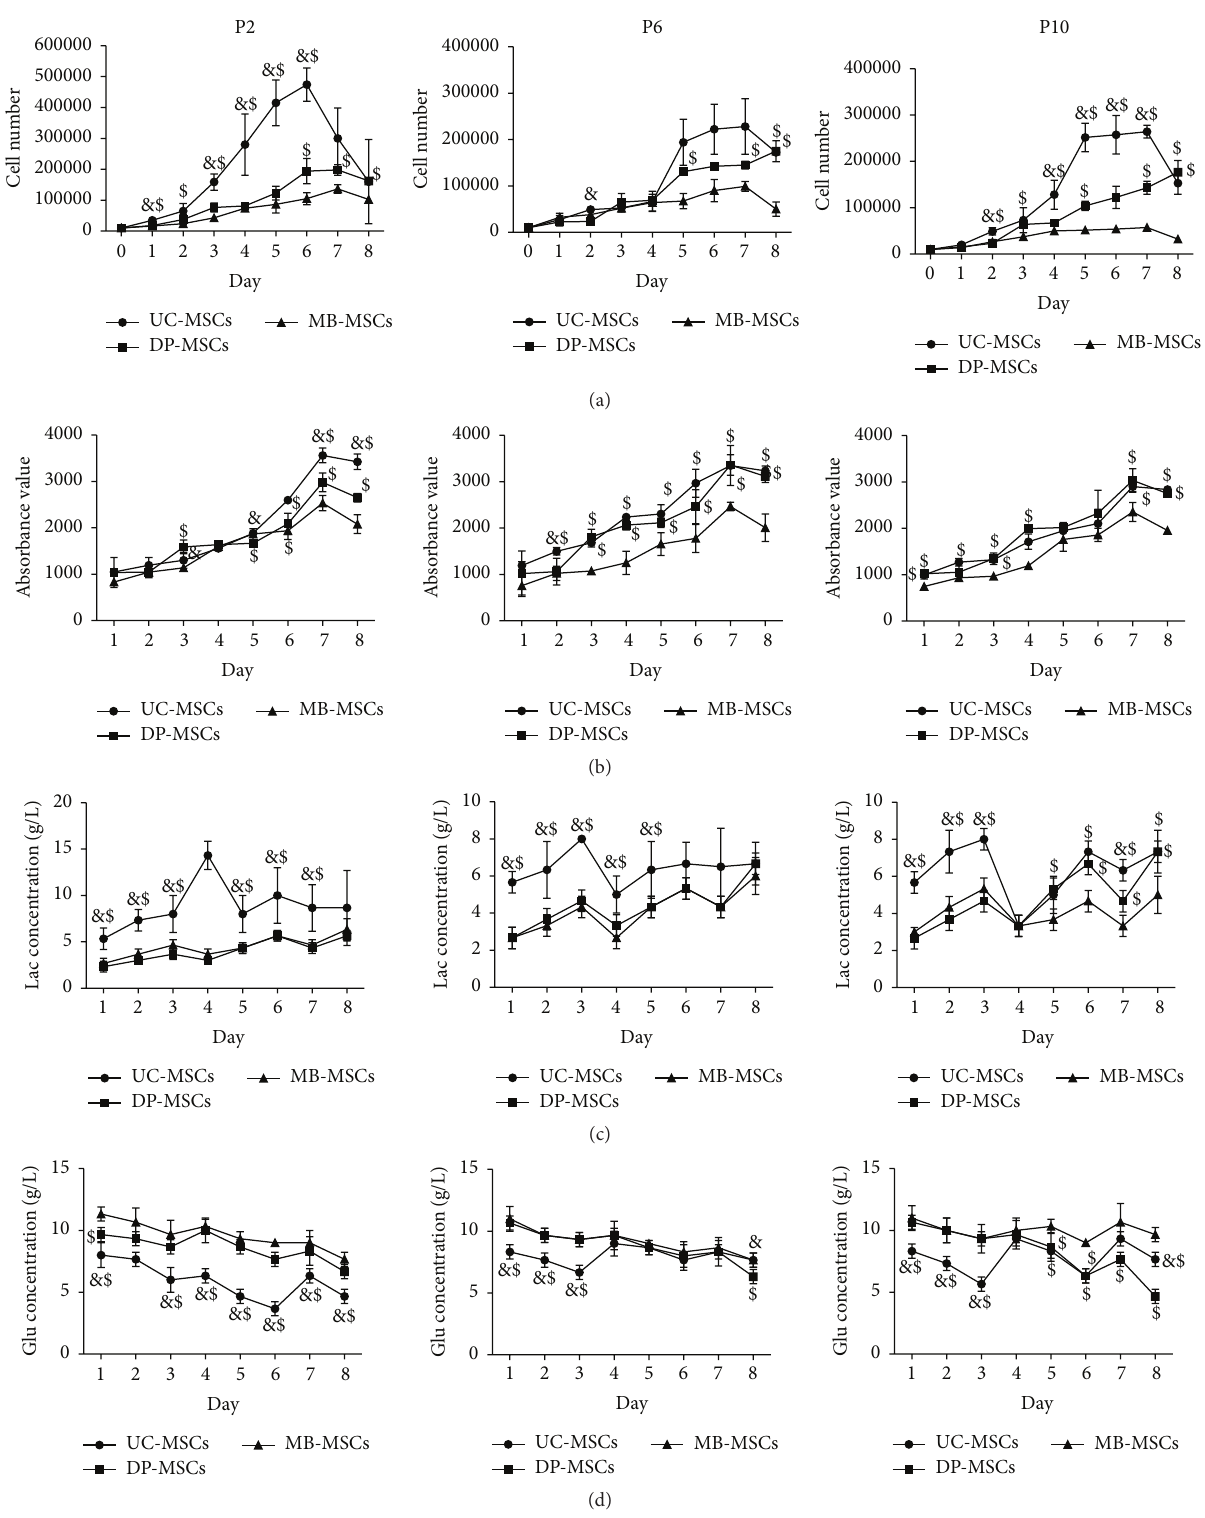
Figure 3: Growth kinetics of UC-, DP-, and MB-MSCs. (a) The cell number determined on an automatic cell counter; (b) cell viability determined by Alamar Blue staining; (c-d) the glucose (Glu) and lactate (Lac) levels monitored using the glucose and lactate biosensors. Each experiment was performed in triplicate: & compared with DP-MSCs at corresponding day; $ compared with MB-MSCs at corresponding day, 𝑝 < 0.05 . UC-MSCs: umbilical cord mesenchymal stem cells; DP-MSCs: dental pulp mesenchymal stem cells; MB-MSCs: menstrual blood mesenchymal stem cells; P: